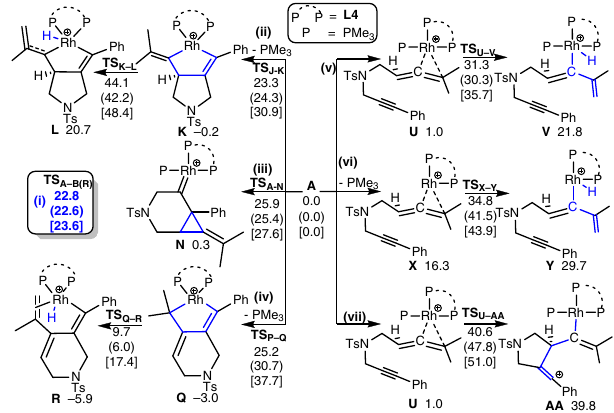
Fig. 5 Computational studies on several pathways. The free energy pro fi les for different reaction pathways of the cationic Rh(I)-catalyzed cycloisomerization of 1,6-allenyne ( 1a ) using a PMe 3 ligand in solution by the SMD M06-L//M06-L method. The relative free energy for the key transition states by SMD PBE0-D3//M06-L and SMD B3LYP-D3//M06-L methods are also given in parenthesis and bracket,